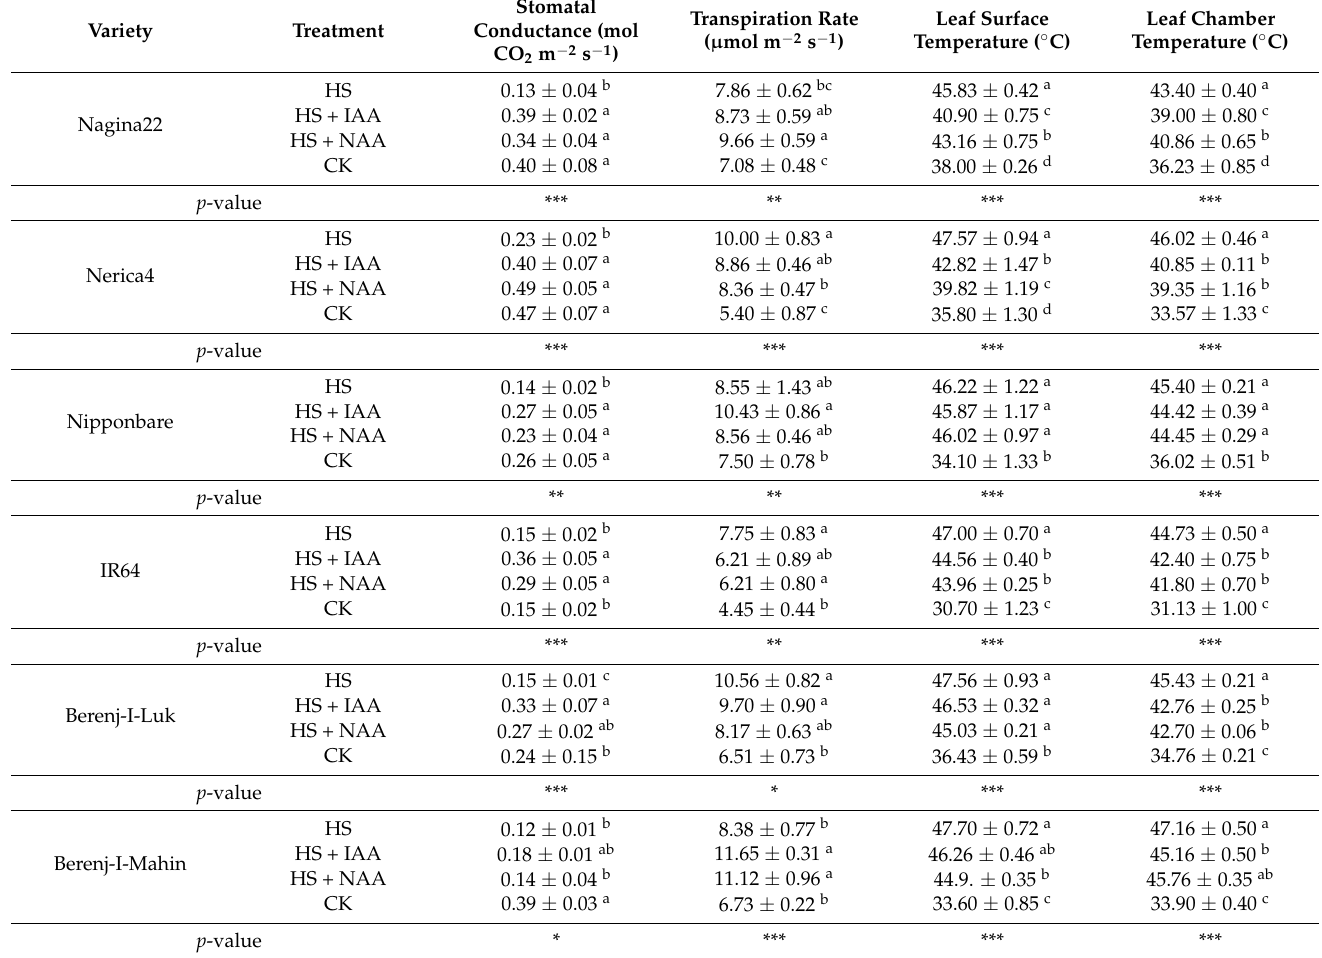
Table 1. Effect of auxin application and heat stress on physiological parameters of six rice